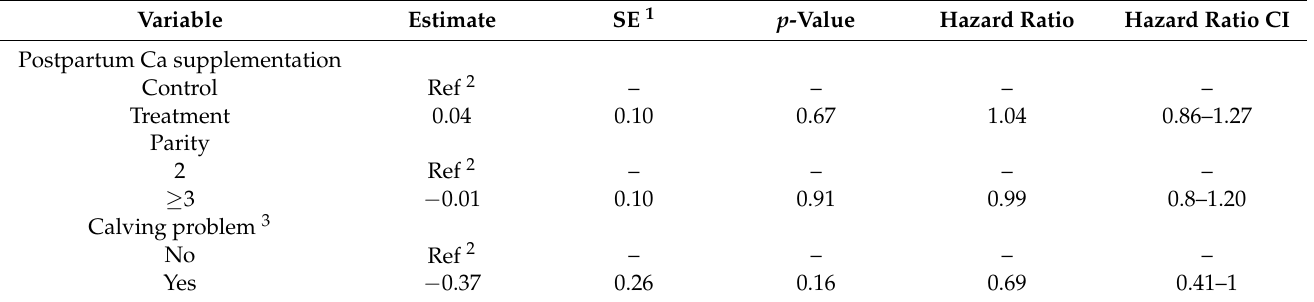
Table 4. Cox proportional hazards model evaluating the effect of an oral postpartum calcium supplementation strategy with reproductive efficiency in a randomized clinical trial in multiparous Jersey cows ( n = 809) in a dairy in west TX. Variable